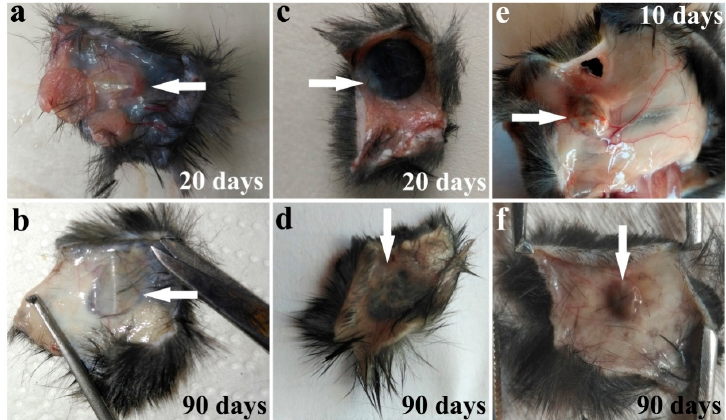
Figure 4. Photos of the implantation zones (marked by arrows) of a PCL ( a , b ) 75 / 25 composite ( c , d ) and metallic glass sample ( e , f ). PCL sample ( a , b ) and 75 / 25 composite sample ( c , d ) stayed in the implantation zone, maintained its shape and size, and did not cause inflammation; pure glass sample ( e , f ) caused the abscess in the implantation zone and was resorbed.